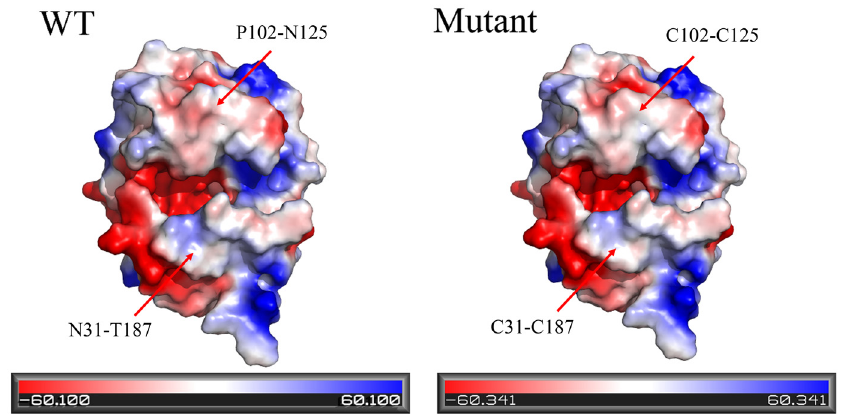
Fig 6. Comparison of electrostatic surface potential of wild-type BglTM and N31C-T187C/ P102C-N125C mutant.